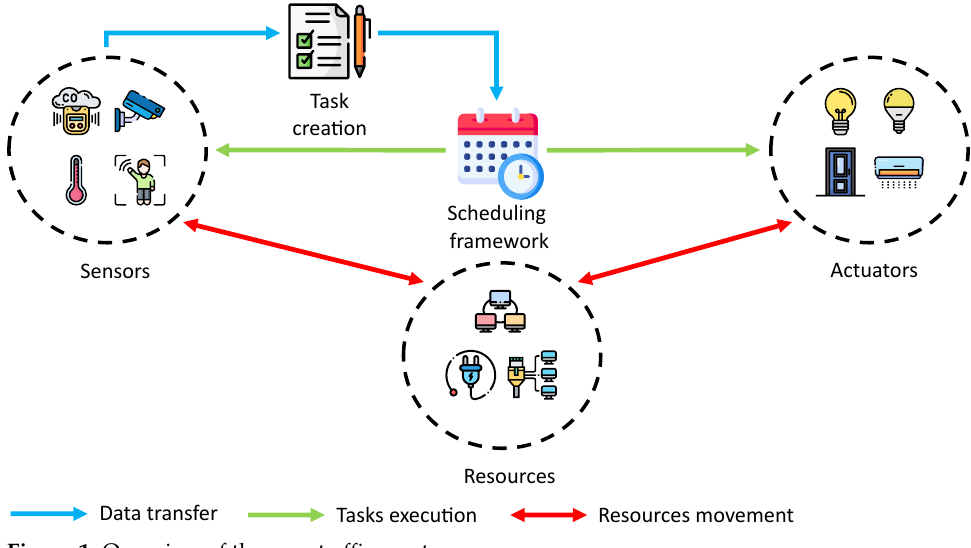
Figure 1. Overview of the smart office system.